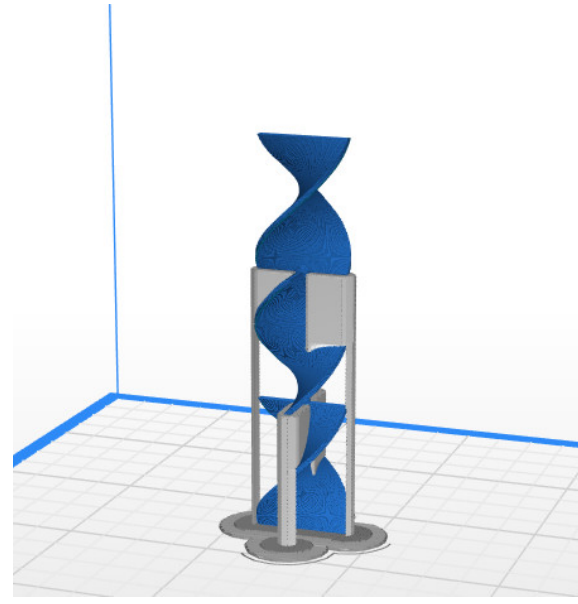
Figure 3. Static mixer model with defined print settings and support structures from Z-suite slicer software